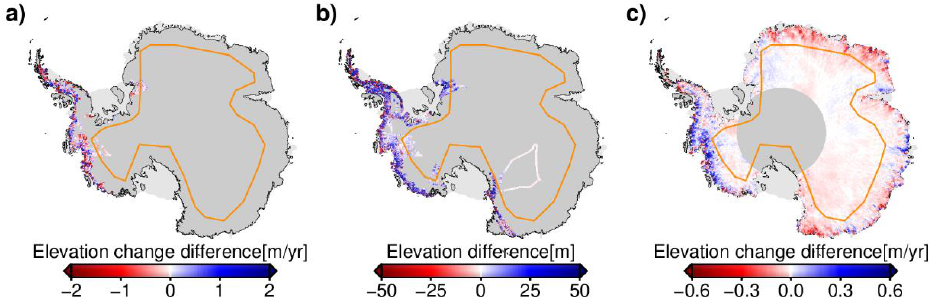
Figure 2. Validation with laser altimeter elevation data obtained from the OIB and ICESat. Differences between the elevation changes derived from OIB observations and the combined elevation time series between 2002 and 2016 ( a ). Elevation differences between OIB observations and the combined elevation time series over the period of 2009–2018 ( b ). Difference between the average elevation change rates from the combined elevation time series and the average ICESat surface elevation change rates between 2003 and 2009 ( c ). The mode mask boundary between the CryoSat-2 LRM and SARIn modes is shown in orange.